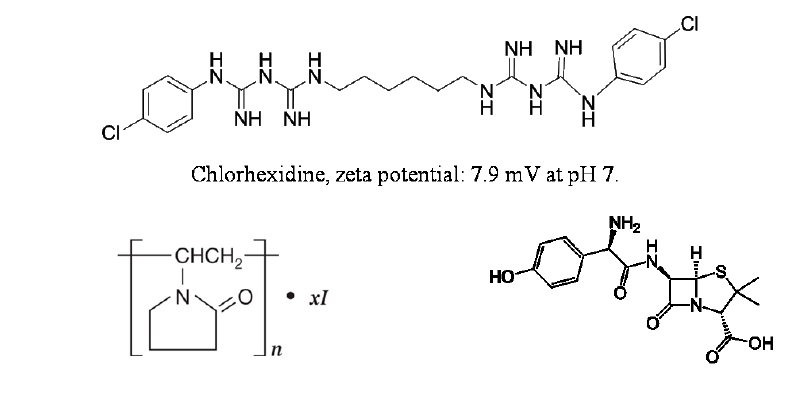
Figure 3. Chemical structure and zeta potential at pH 7 of commonly used antibacterial compounds.